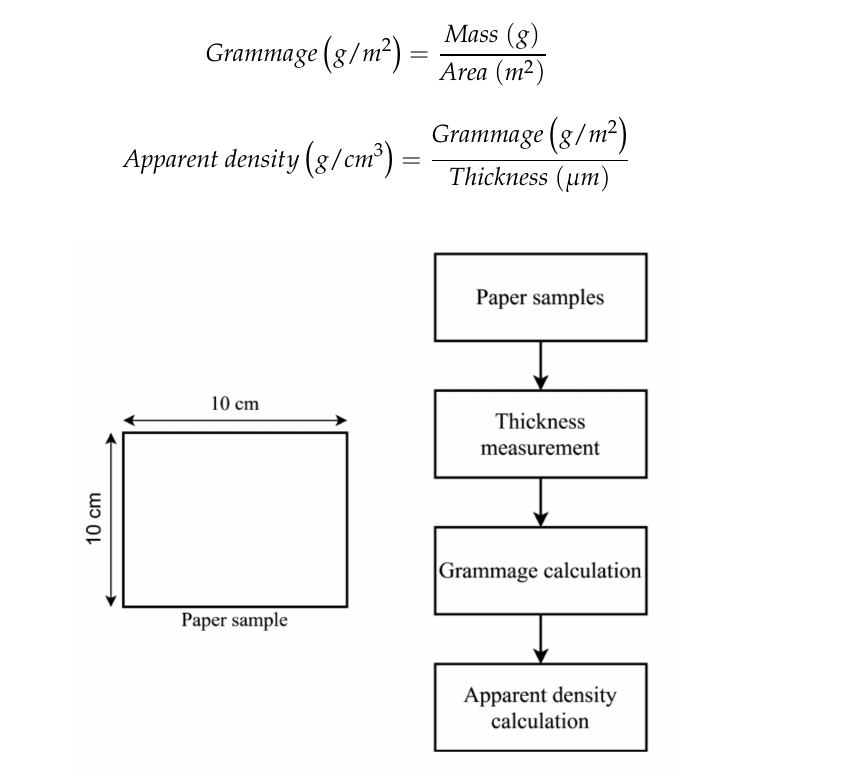
Figure 10. Grammage and apparent density